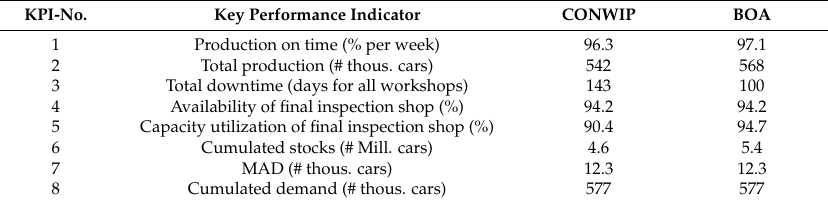
Table 6. Case study 3—Results.